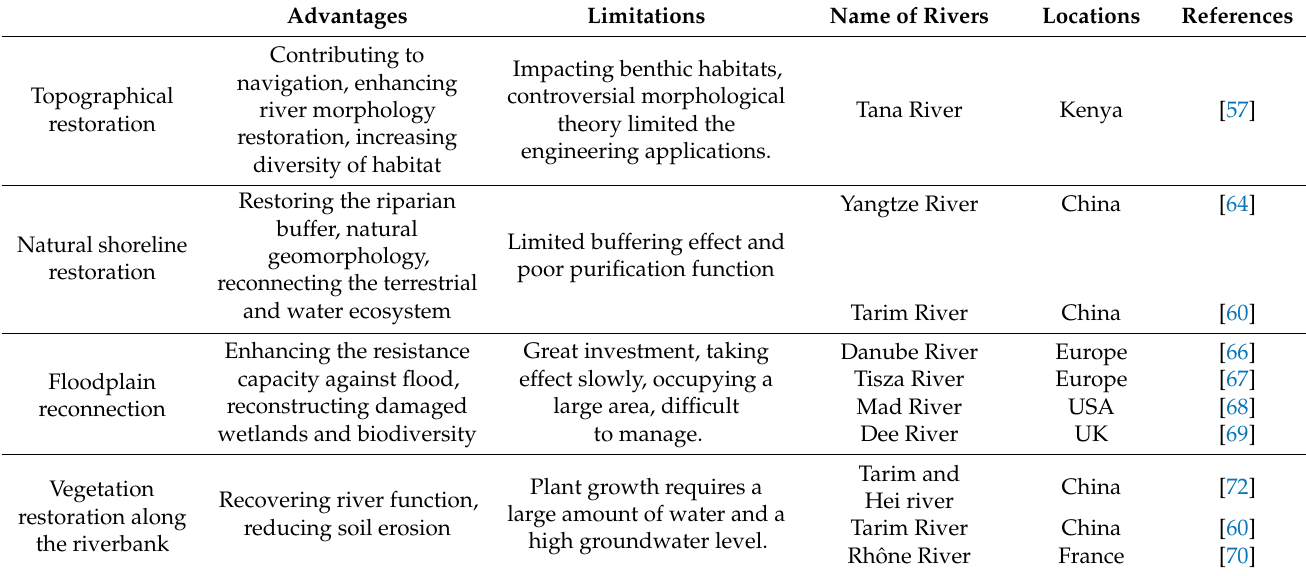
Table 3. Advantages and Limitations of different ecological geomorphological